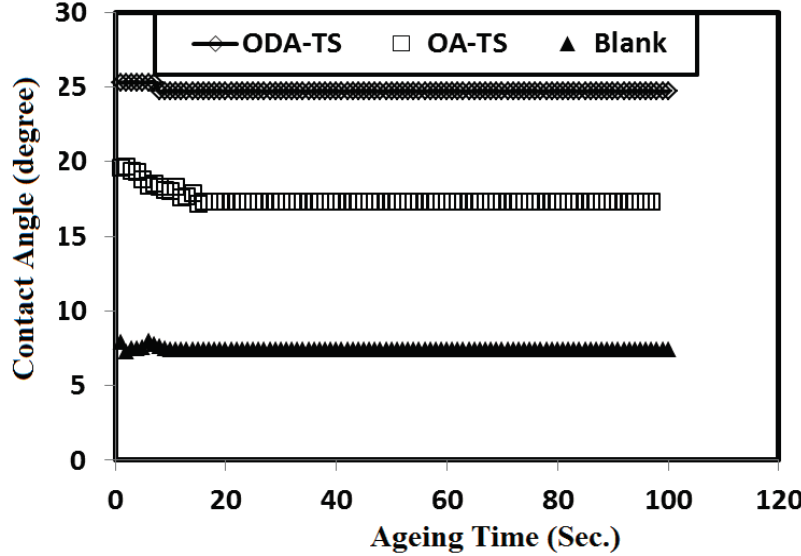
Figure 8. Relation between contact angle measurements and at ageing time at steel surfaces of different concentrations of OA-TS and ODA-TS in 1 M HCl aqueous solutions.